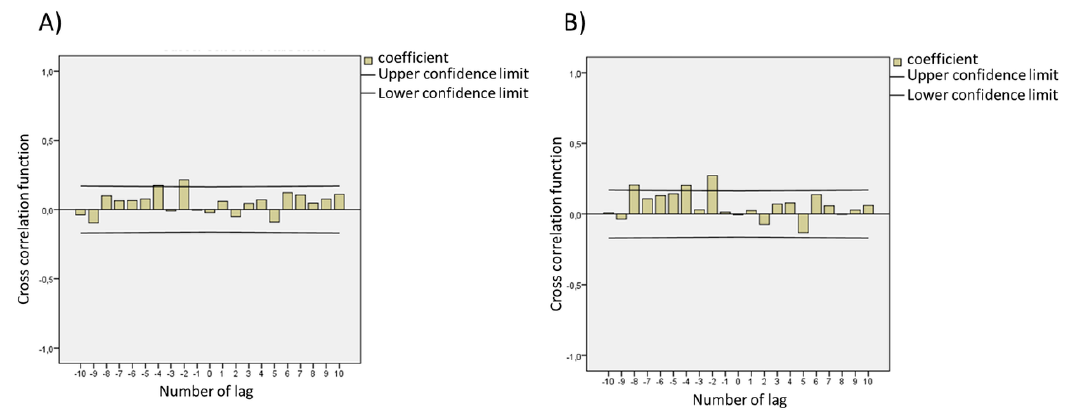
Figure 2. Modeling reveals that the time delay between clinical case reporting and wastewater data changes over the course of the pandemic using (A) SARS-CoV-2 N1 target and (B) SARS-CoV-2 N2 changes over the course of the pandemic using ( A ) SARS-CoV-2 N1 target and ( B ) SARS-CoV-2 N2 target. The confidence limit applied was 95%. target. The confidence limit applied was